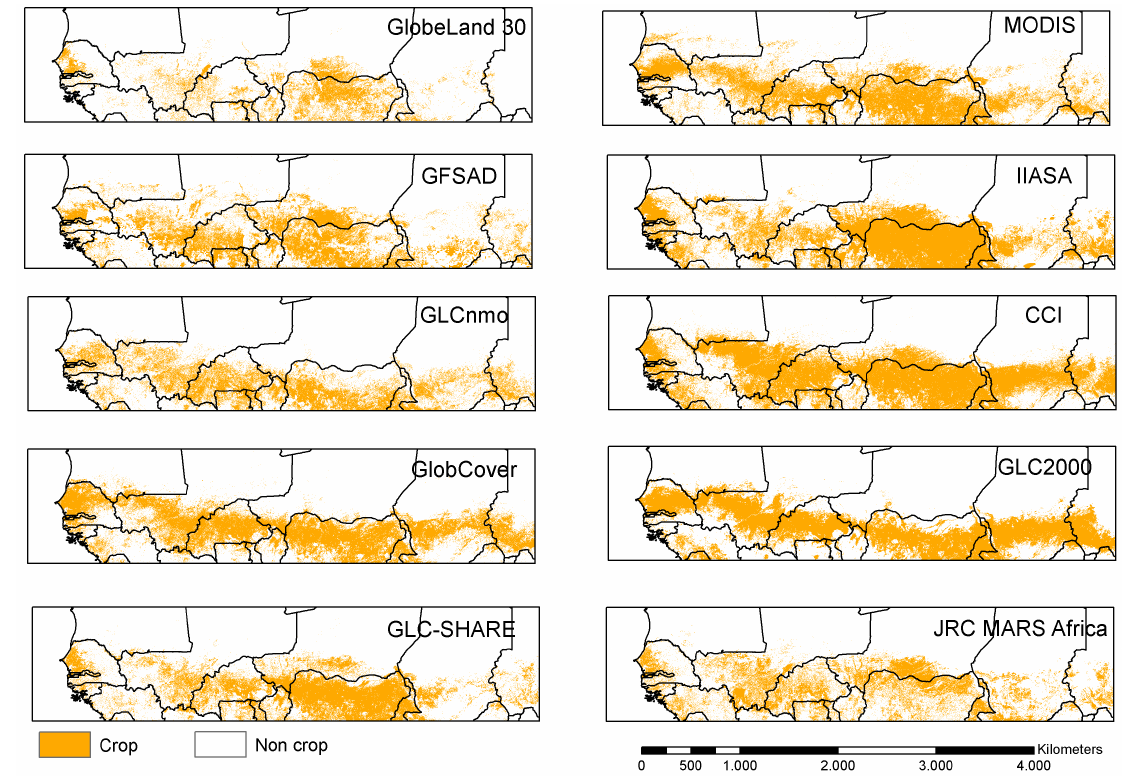
Figure 1. Cropland over Sahelian and Sudanian agrosystems on ten global products showing the high variability of cropland